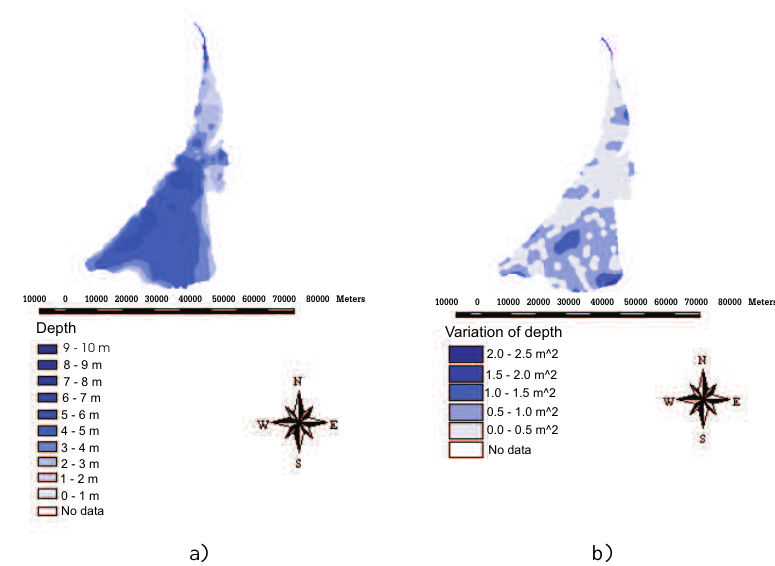
Figure 5. Cokriging method: a) prediction map of fraction (7); b) variation map of fraction (7).